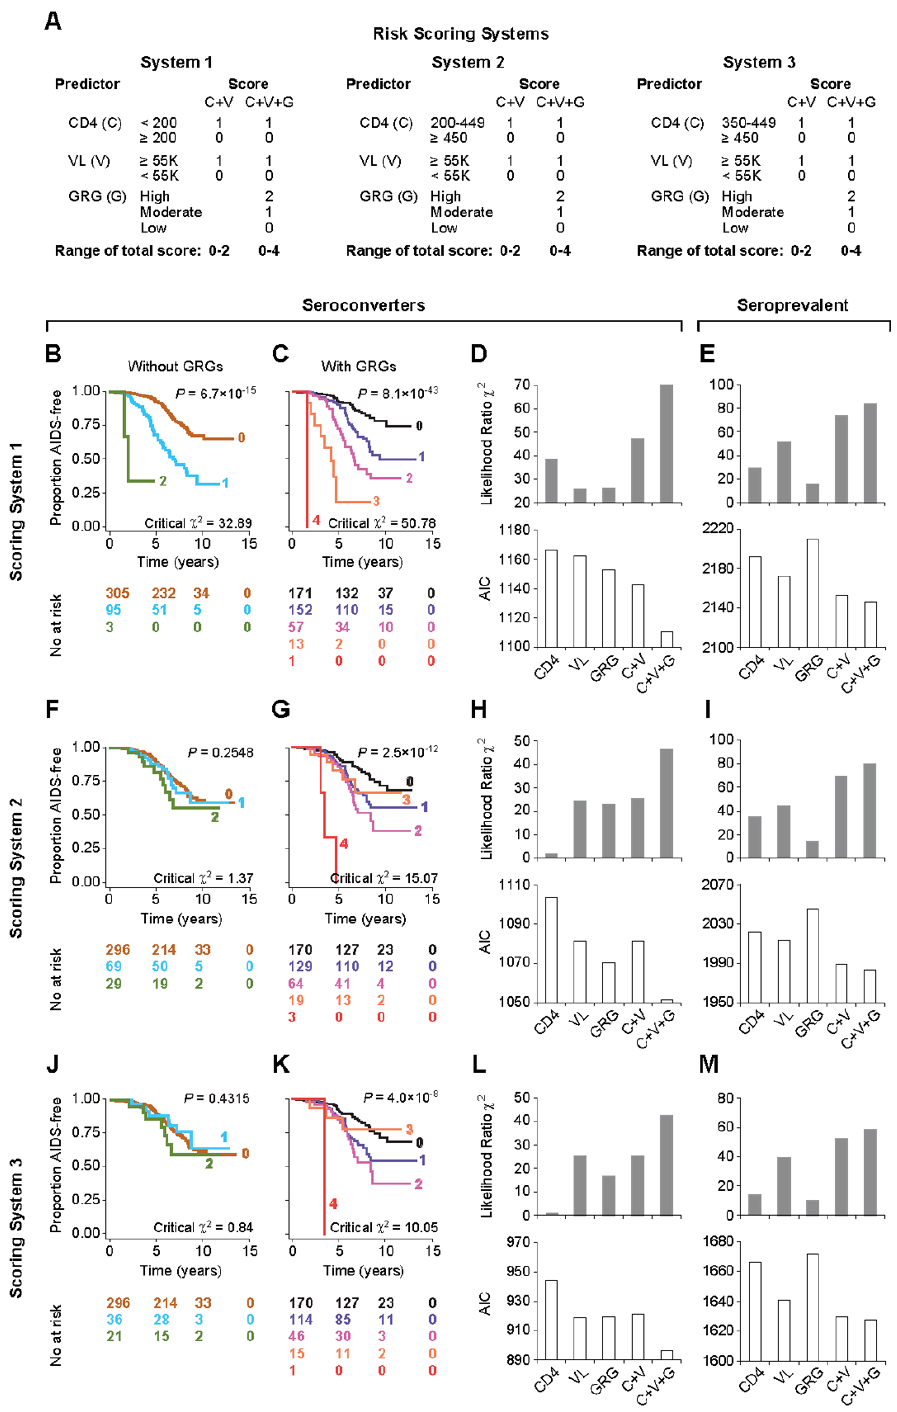
Figure 1. Prognostic performance of the CCL3L1-CCR5 GRGs in risk-scoring systems. Panel A shows the three risk-scoring systems based on baseline CD4 + T cell counts (C), viral load (V) and GRGs (G) in the seroconverting and separately in the seroprevalent component of the WHMC HIV + cohort. Panels B–C, F–G and J–K depict Kaplan Meier (KM) plots for progression to AIDS (1987 criteria) before and after accounting for the GRGs in the risk-scoring systems indicated on the left axis. The critical ratio x 2 values are indicated within the KM plots. Panels D, H and L depict likelihood ratio x 2 and AIC estimates in seroconverters, and panels E, I and M depict the same estimates for the seroprevalent subjects.